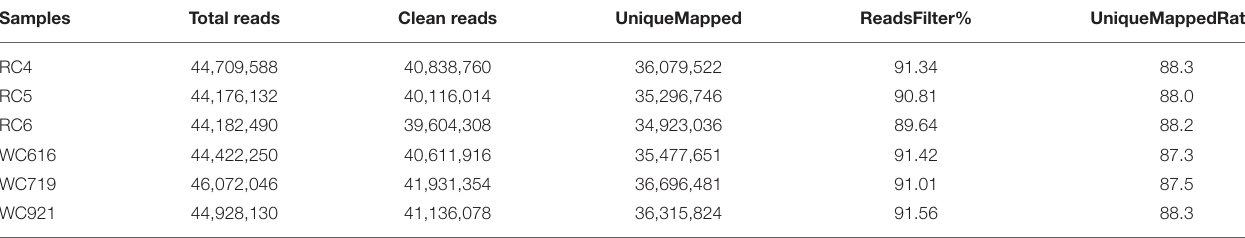
TABLE 1 | Details of sequencing data by RNA-seq. Samples